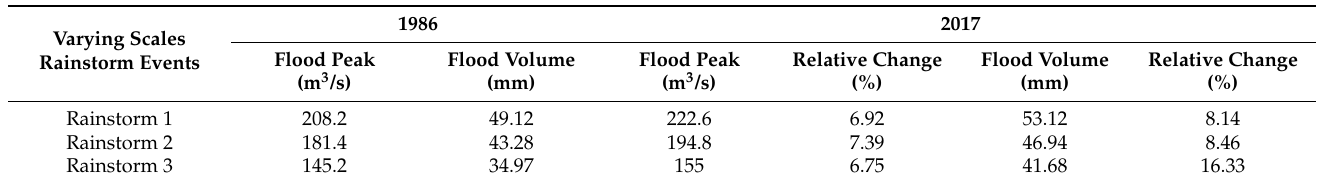
Figure 7. Relative change in flood peak discharge and flood volume considering various urban land cover increases (1986–2017) in three varying scales rainstorm events: ( a ) Rainstorm 1, ( b ) Rainstorm 2, and ( c ) Rainstorm 3. Table 4. Modeling comparison of flood peak and flood volume simulation results considering land use/cover in 1986 and in